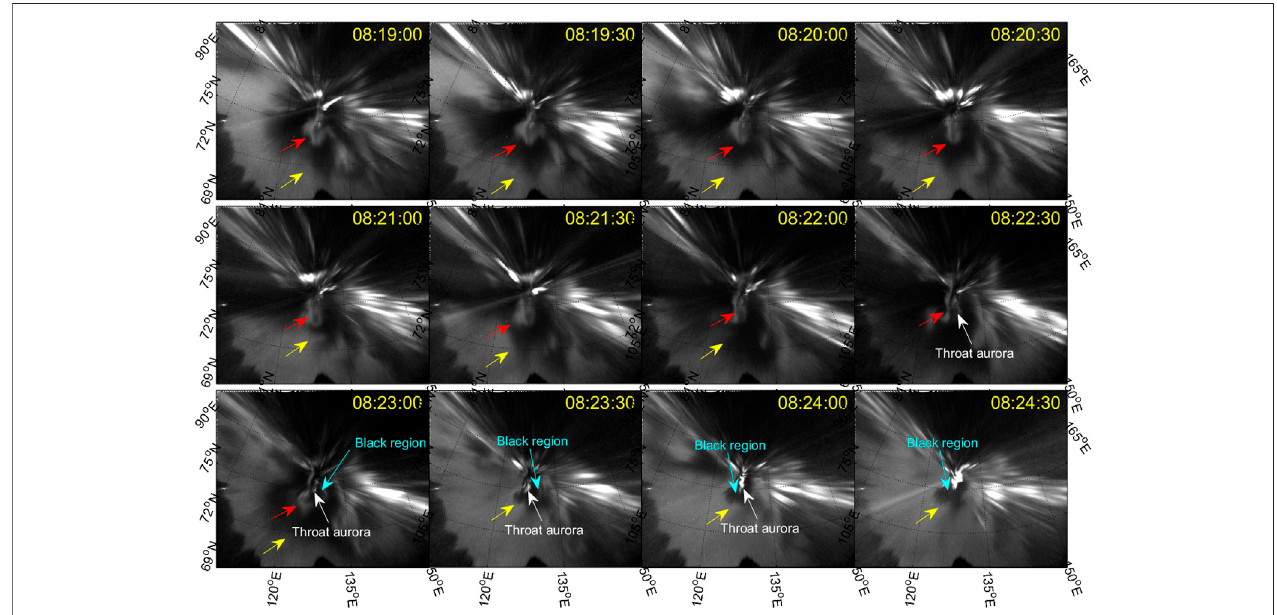
FIGURE2| Atypical case observed onNov. 27,2008forshowing howthe diffuseauroras canbe used toanalyze thedayside magnetospheric processes. Yellow and red arrows indicate Type 1 and Type 2 diffuse auroras, respectively. Type 2 diffuse aurora is believed to be related to the penetrated magnetosheath particles. A throat aurora is developed from the Type2 diffuse aurora from 08:22:30UT. At the same time, a black region is appeared. From 08:23:30, the Type 1 diffuse aurora drift poleward but cannot come into the black region, which means the fi eld lines threading the black region is opened.